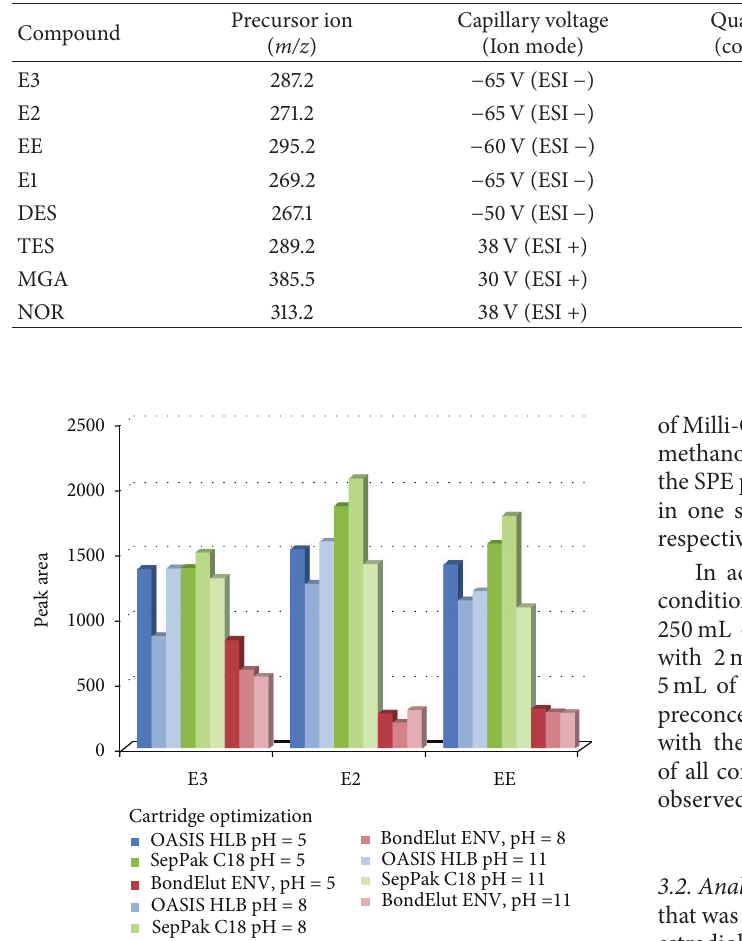
Figure 1: Optimization of SPE